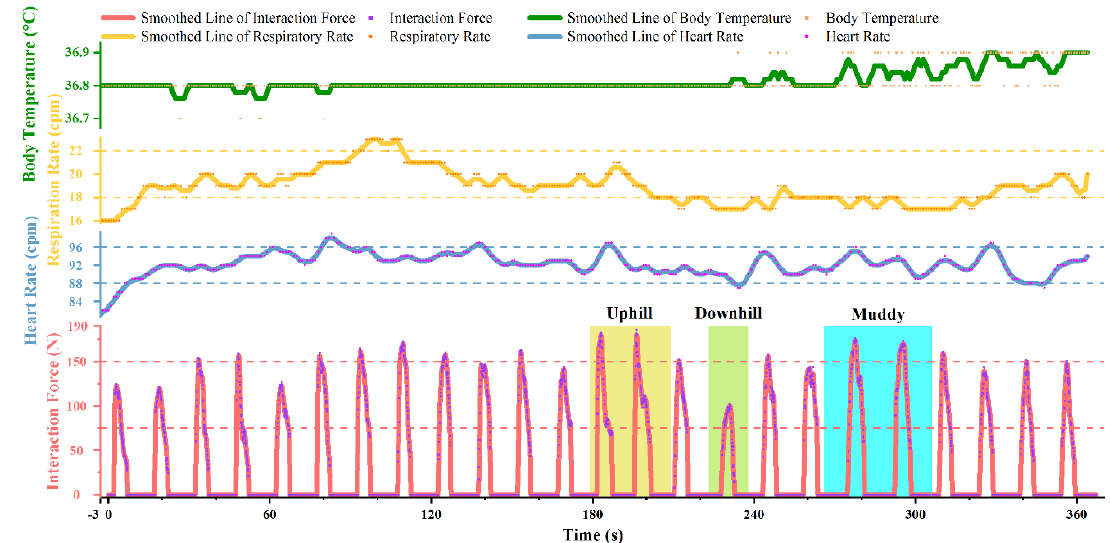
Figure 8. Recorded variation of one subject’s physiological signals and interaction force during the strength training. The training started in the 0 s, and the physiological signals recorded before 0 s were resting values.